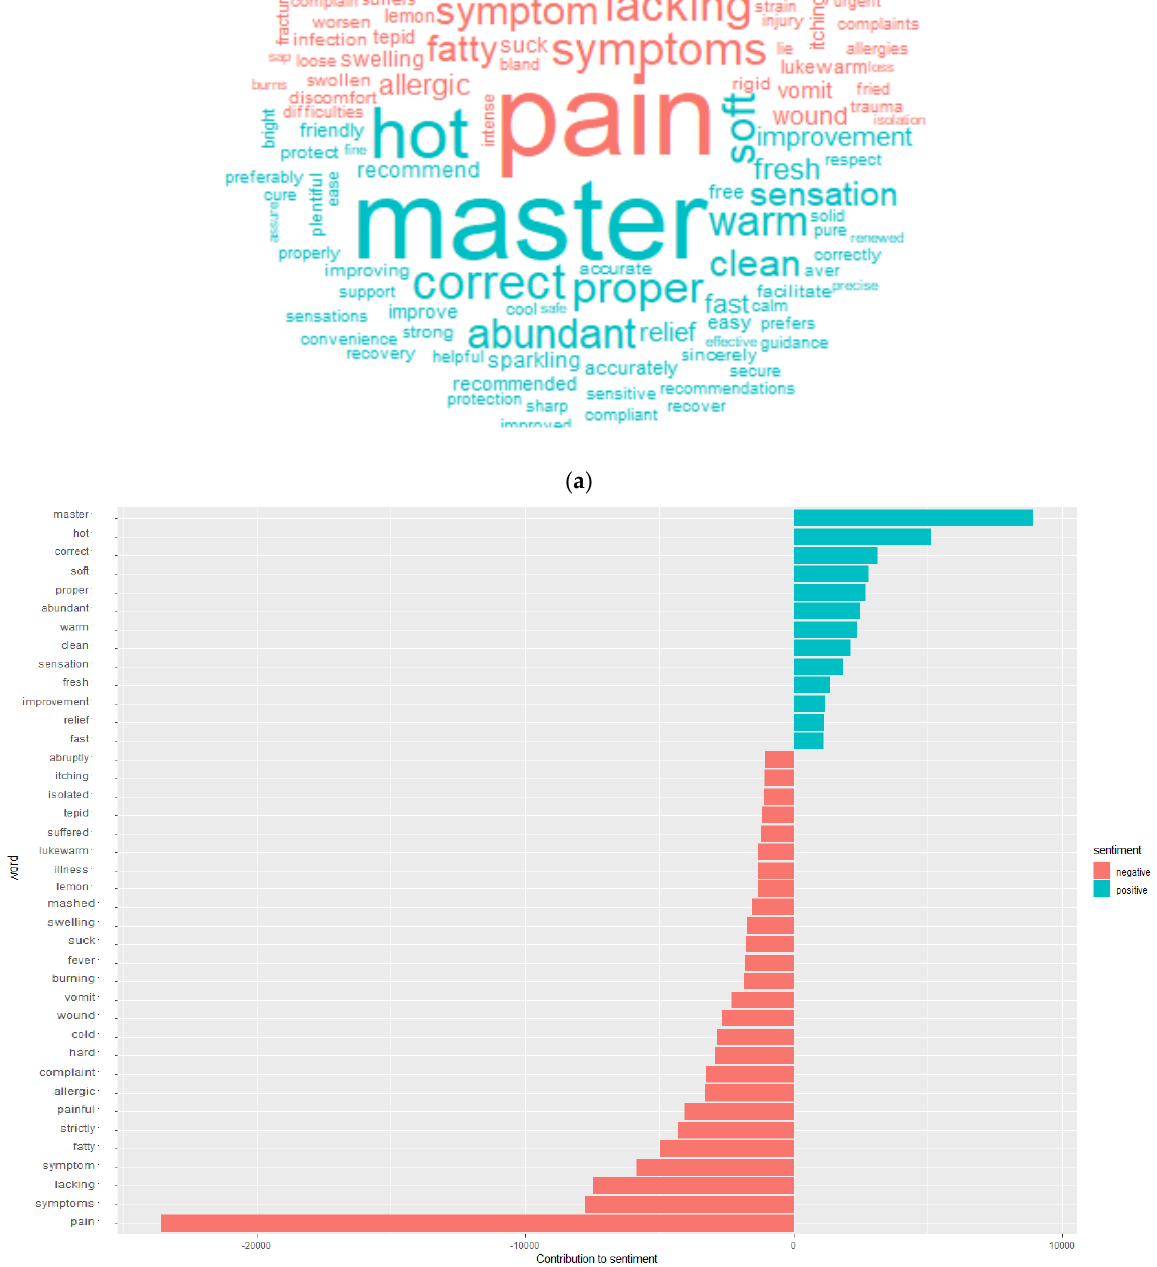
Figure 4. ( a ). Word cloud picturization of positive (green) and negative (red) sentimental words (most of the word alignments are associated with words pain, master, symptoms, hot, correct, lacking etc.). ( b ). Word count that contributes both negative and positive sentiments; the ‘pain’ word had the highest negative sentiment count (23,557) and the ‘master’ word has the highest positive sentiment count